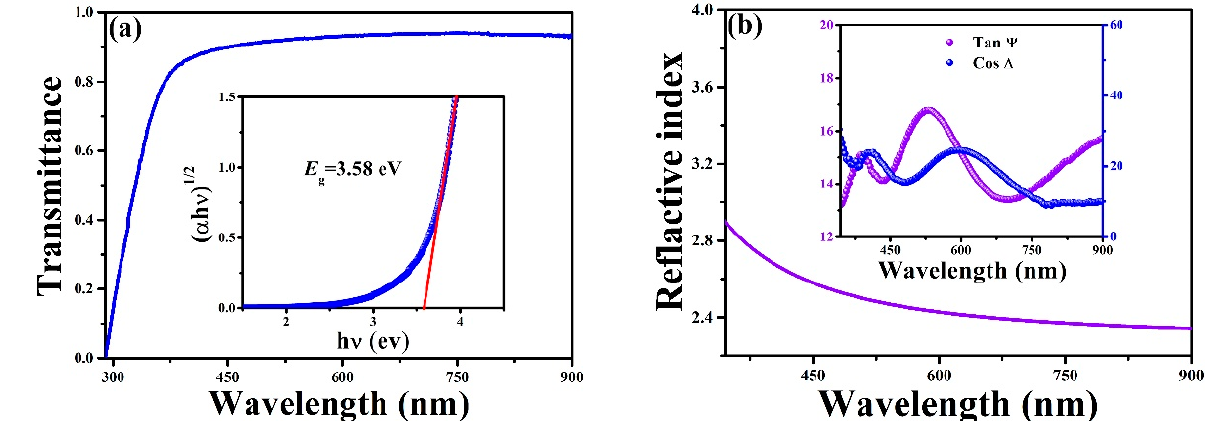
Figure 5. ( a ) Transmittance curve of the resulted BST. The inset reveals the corresponding calculated band gap. ( b ) Refractive index of BST as a function of wavelength. The inset is the Tan Ψ and Cos Δ from the ellipsometry measurement.